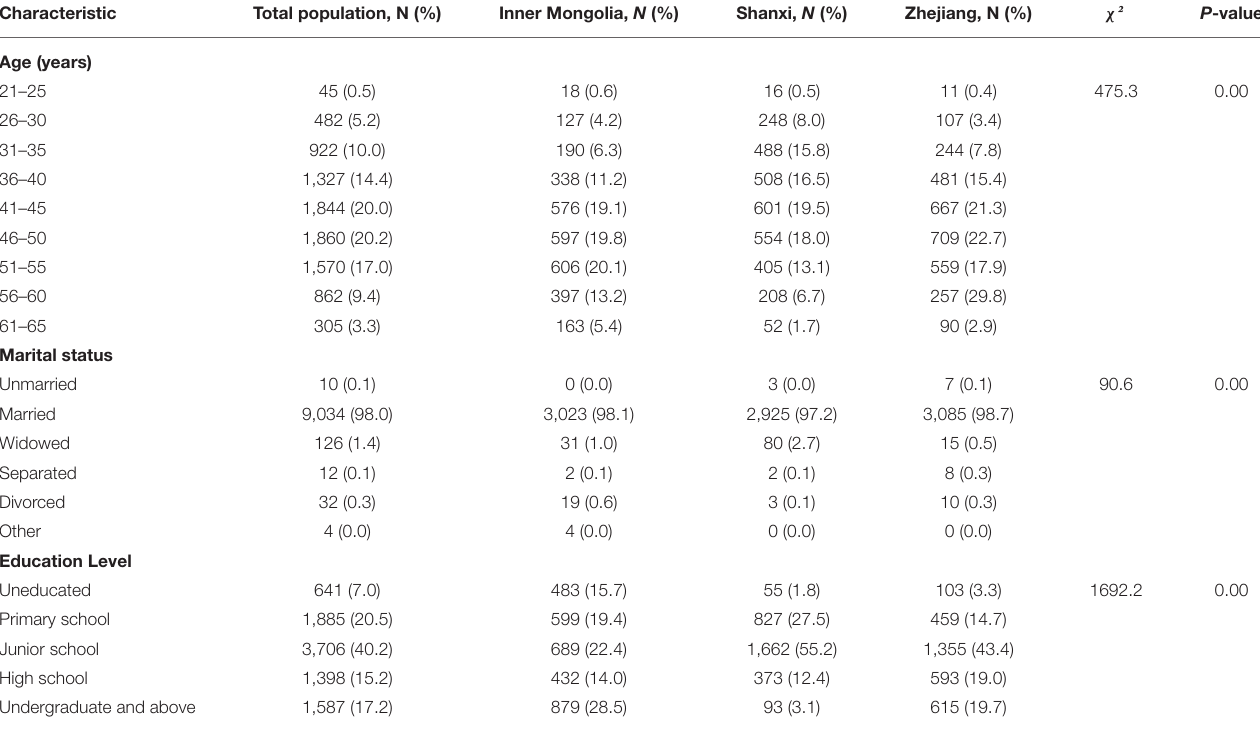
TABLE 1 | Basic characteristics of the study population.